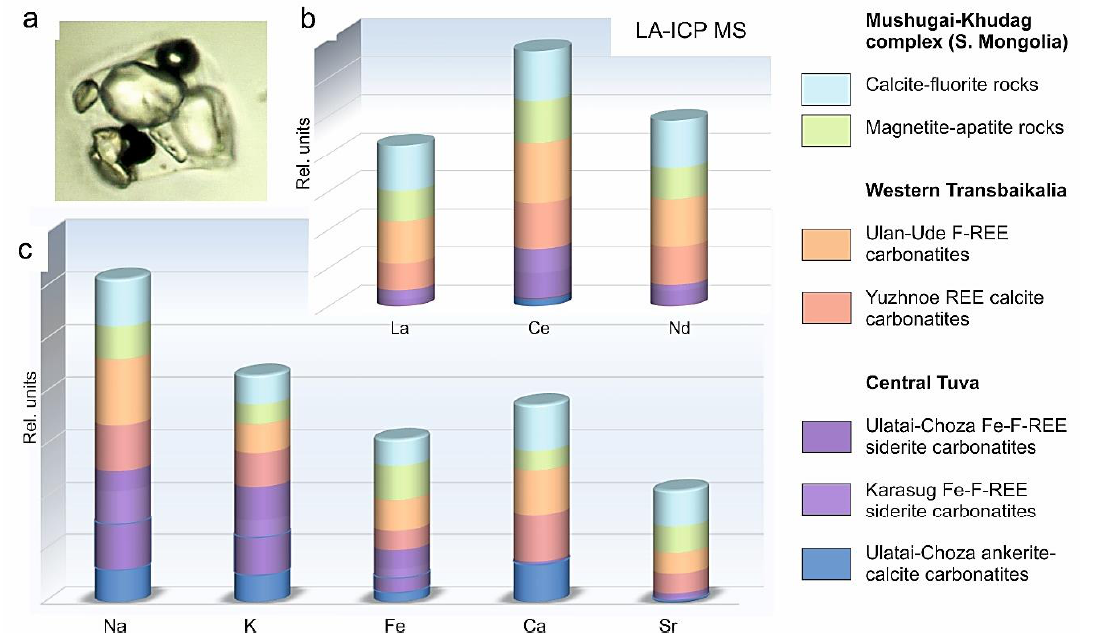
Figure 5. Results from LA-ICP-MS investigations on brine – melt inclusions in the alkaline complexes of the Central Asian carbonatite province. ( a ) Representative microphotograph of a brine – melt inclusion. ( b , c ) Stacked bars of relative element concentration in brine – melt inclusions of different origins.